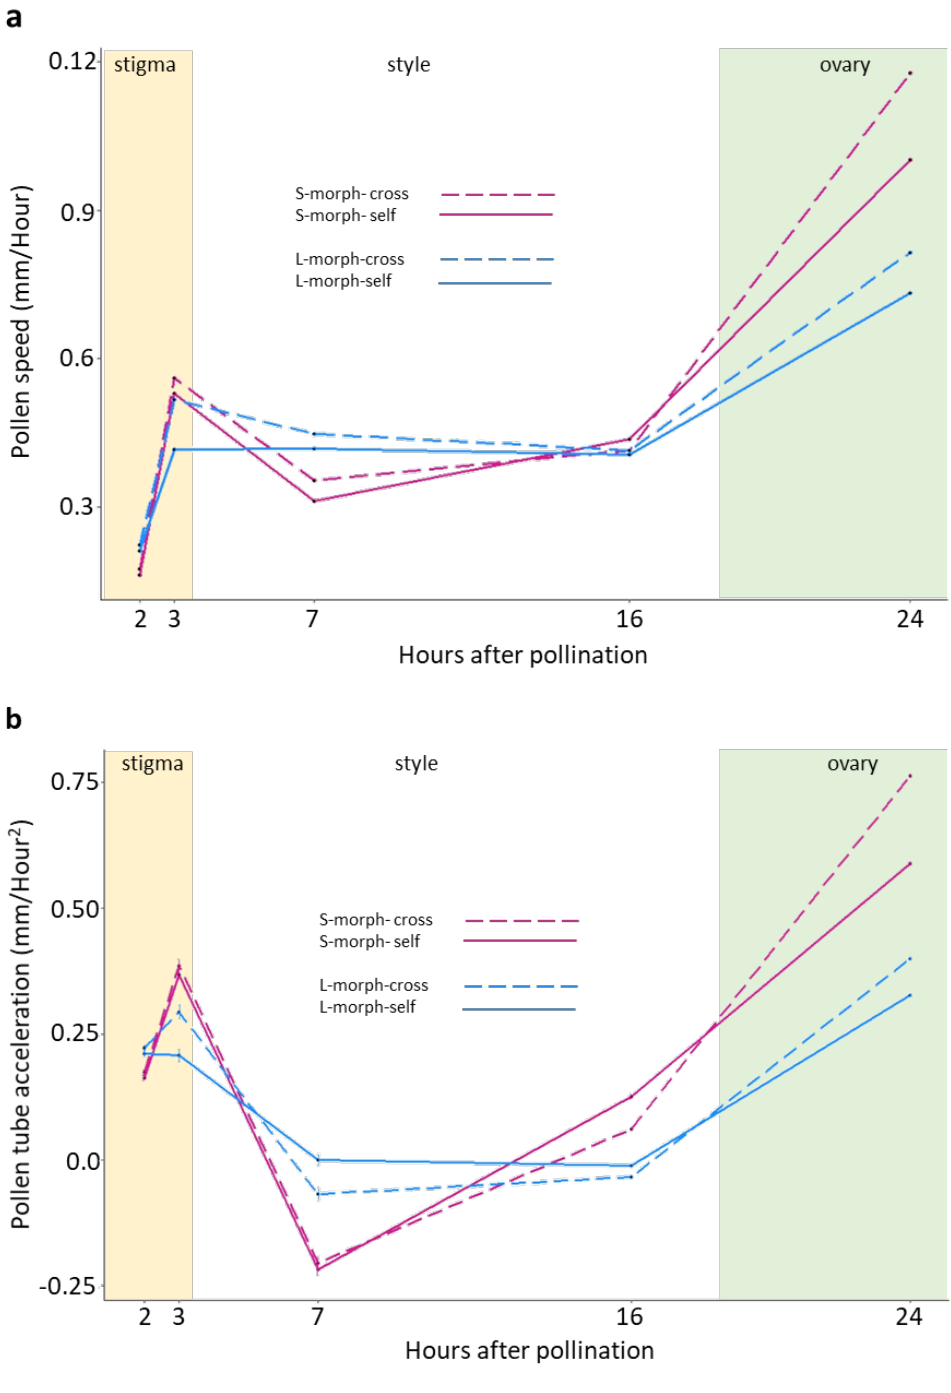
Figure S2: Speed and acceleration of pollen tube elongations in both floral morphs in Ludwigia grandiflora subsp. hexapetala after self- and cross-pollinated. Pink = S-morph, blue = L-morph; solid line = self-pollination (self) and dotted line=cross-pollination (cross). a) Speed of pollen tube elongations in both S-morph and L-morph styles after self and cross pollinations. b) Acceleration of pollen tube elongations in both S-morph and L-morph styles after self and cross